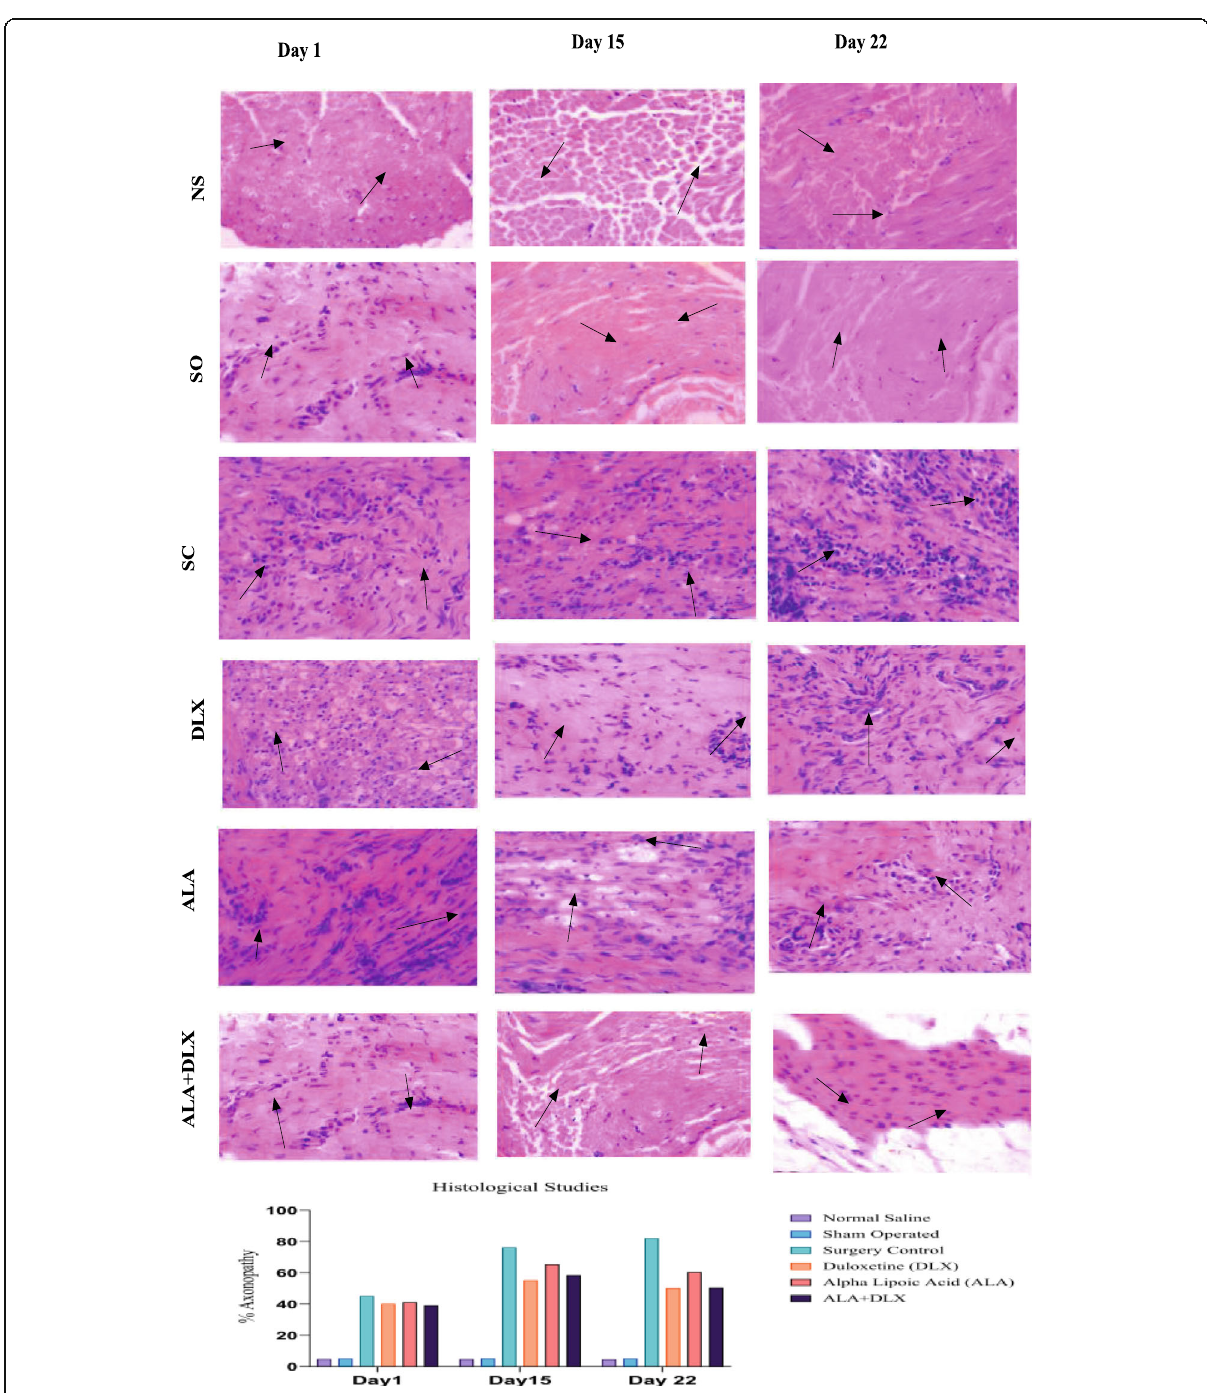
Fig. 3 Histopathology of sciatic nerve section (400 X) of normal, sham operated, surgery control, DLX, ALA and, DLX + ALA groups taken on 1st, 15th and 22nd days of study. The arrows indicate the appearance of axons and myelin sheaths of different groups. The graph below indicates the percentage (%) of axonopathy in different groups on 1st, 15th and 22nd days of